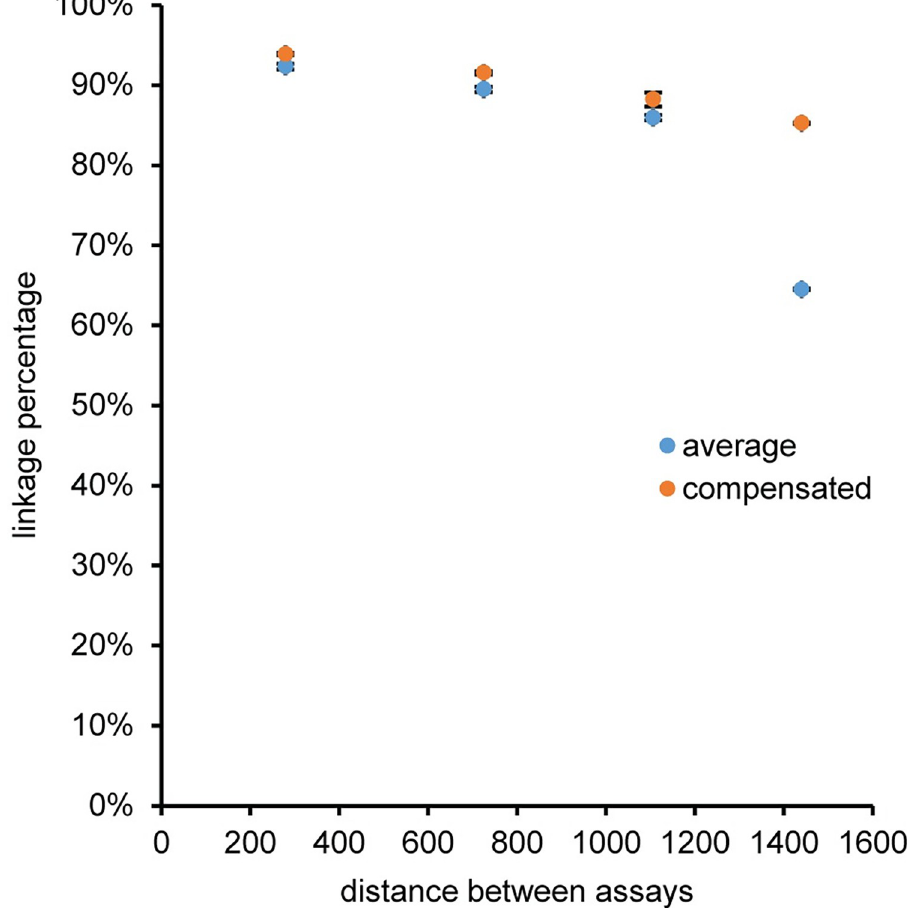
Fig 13. Linkage percentage of AAV2. The viral vector AAV2 was lysed prior to droplet formation for 1 minute at 95˚C and then used as a template for a milepost experiment using CMV-Enh_s-FAM as the anchor assay and either CMV-Pro, eGFP, GFP-L or SV40 as the HEX assay. The linkage percentage was calculated using equations based on an average concentration for the FAM and HEX assays (average) or equations that compensated for differences in assay concentration between the FAM and HEX assay (compensated). The error bars represent the standard deviation and are smaller than the marker when not visible.